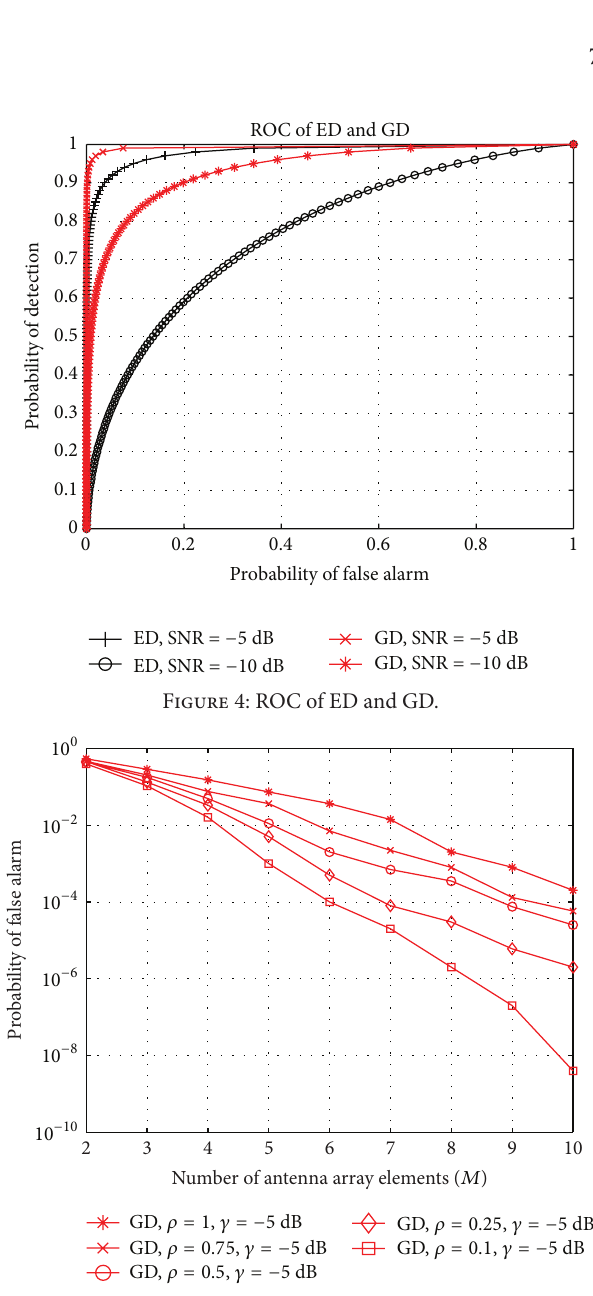
Figure 5: Theprobability offalsealarm for GD versusthenumber of antenna array elements at various values of the coefficient of corre-